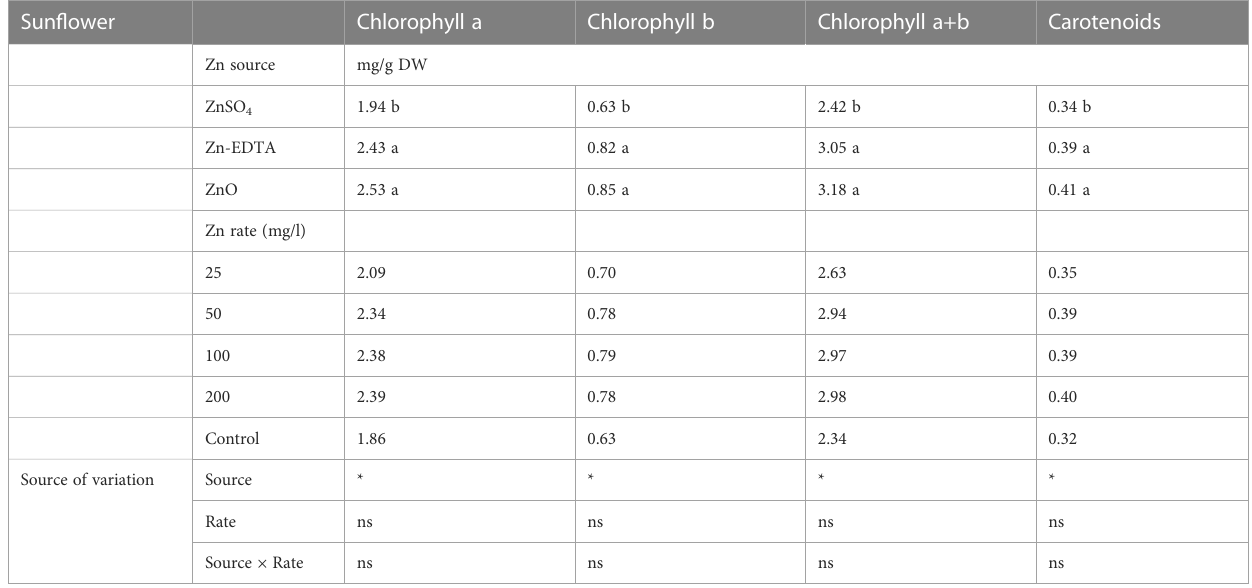
TABLE 8 Chlorophyll a, chlorophyll b, chlorophyll a+b, and carotenoid pigments in sun fl ower microgreens nutri-primed with different sources of Zn and concentration rate.